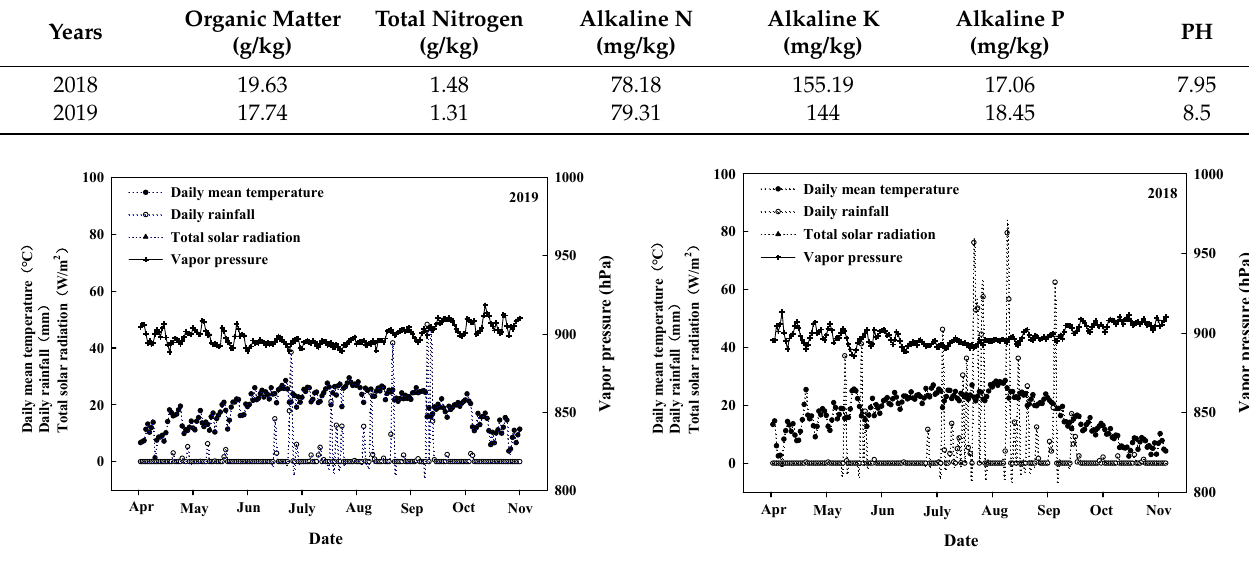
Table 1. Soil basic fertility in the test area.